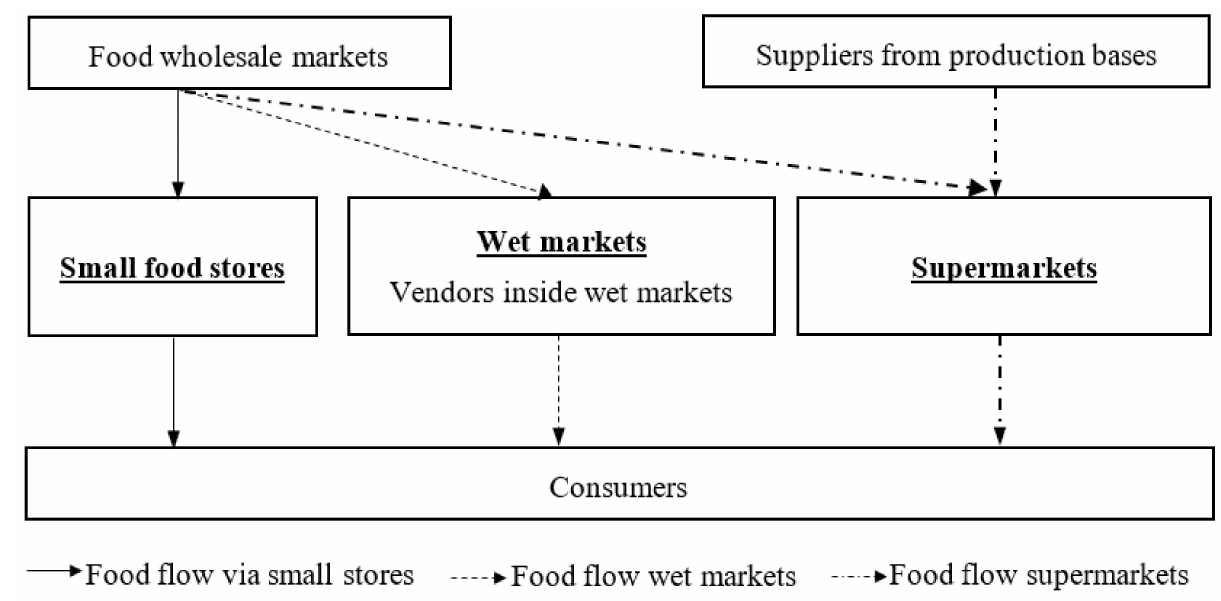
Figure 4. Households’ food sources in